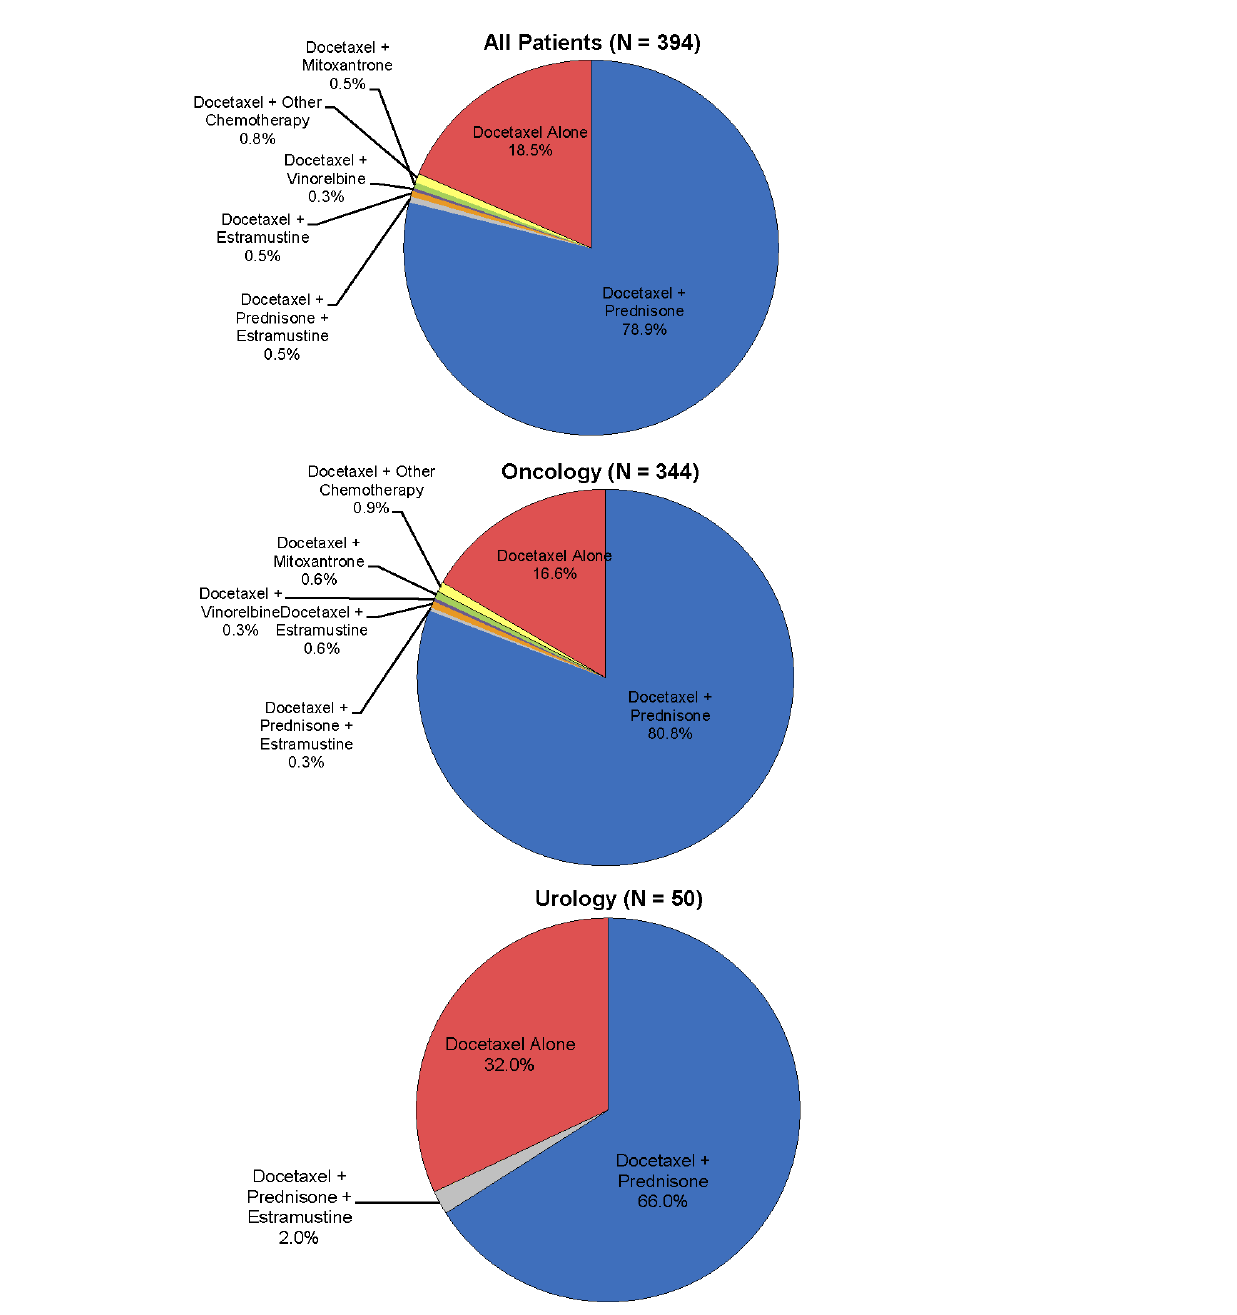
Figure 1. Docetaxel-Based Regimen Initiated, by Specialty of Treating